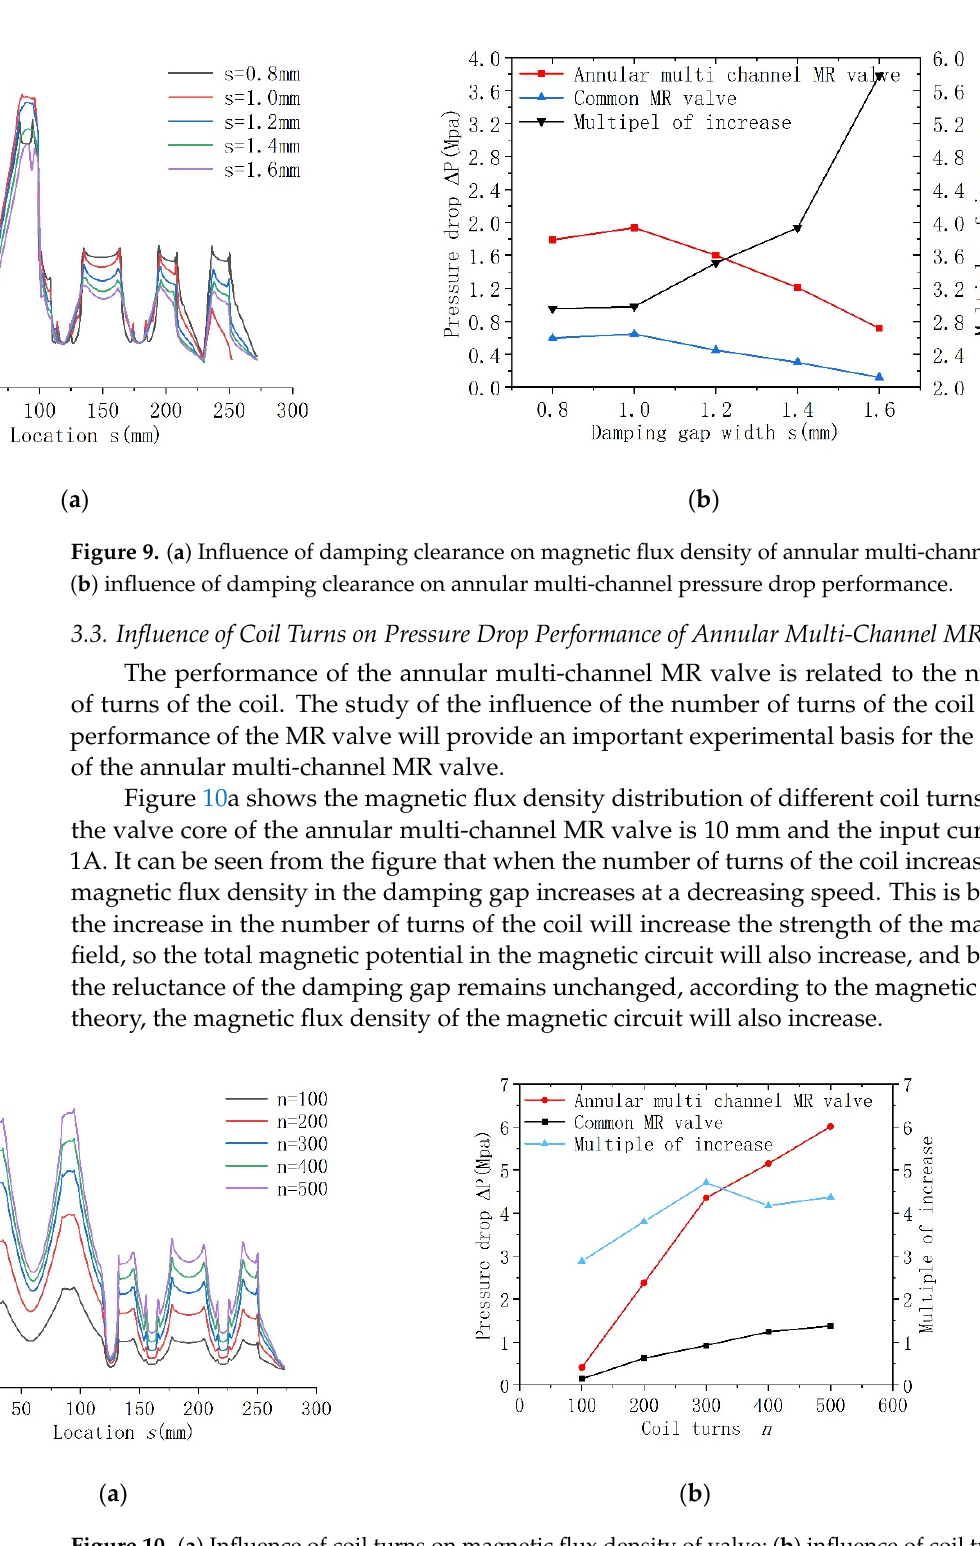
Figure 10. ( a )Influence of coil turns on magnetic flux density of valve; ( b ) influence of coil turns on valve pressure drop performance. valve pressure drop